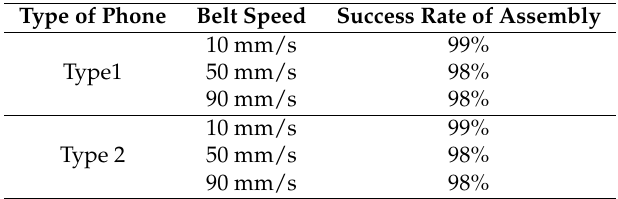
Figure 15. Robot trajectories of different initial points. Table 6. Assembly success